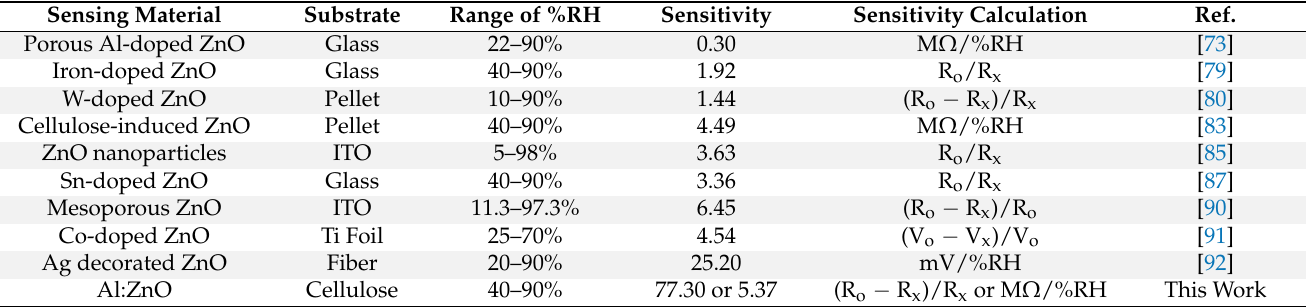
Table 4. Comparison of the humidity-sensing performance of the Al:ZnO nanostructured-based flexible humidity sensor with other reported dopant-induced ZnO-based humidity sensor devices.